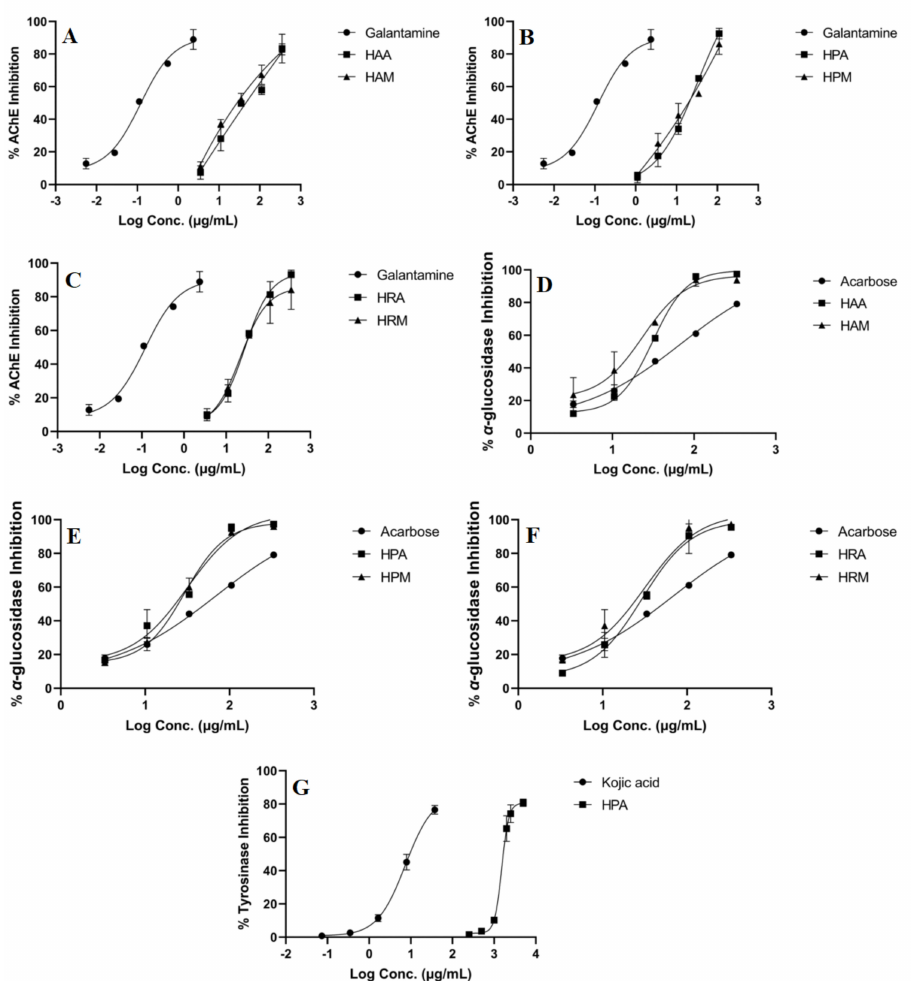
Figure 1. Enzyme inhibition curves of Hypericum extracts against acetylcholinesterase (AChE, ( A – C )), α -glucosidase ( D – F ) and tyrosinase ( G ). HAA ( H. alpigenum MSA extraction), HAM ( H. alpigenum maceration), HPA ( H. perforatum MSA extraction), HPM ( H. perforatum maceration), HRA ( H. rochelii MSA extraction), HRM ( H. rochelii